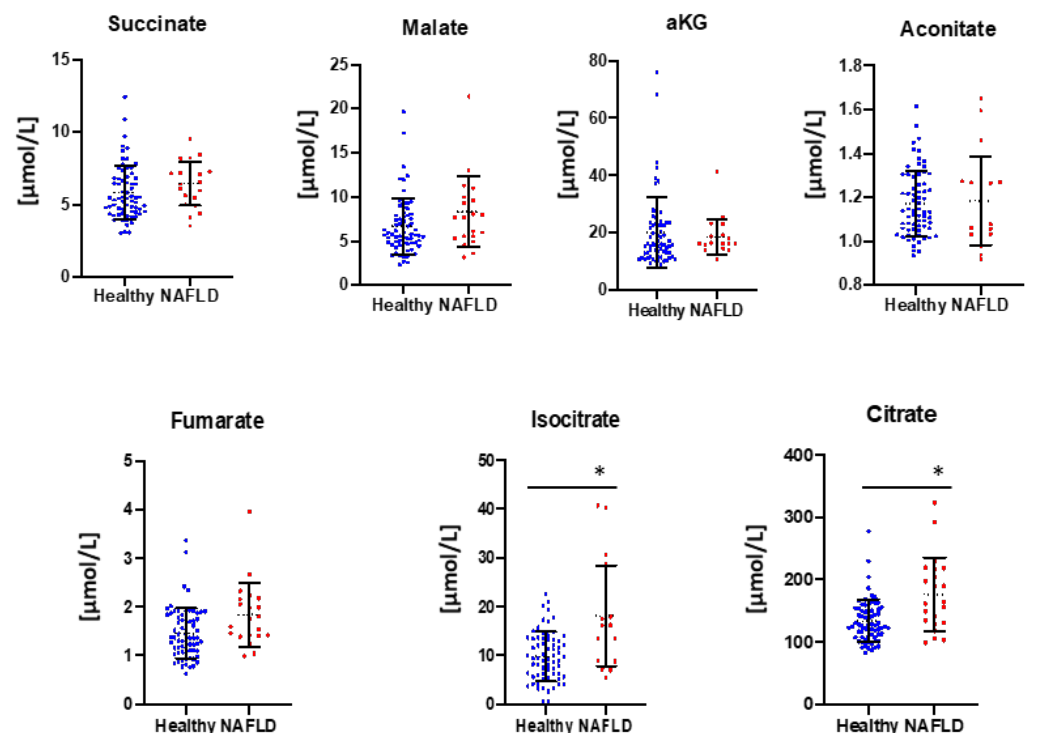
Figure 1. Plasma Krebs cycle intermediates levels by GCMS. Nonalcoholic fatty liver disease (NAFLD) ( n = 22) and controls ( n = 67). Statistical analysis performed by Prism 8 (GraphPad). * p < 0.05.